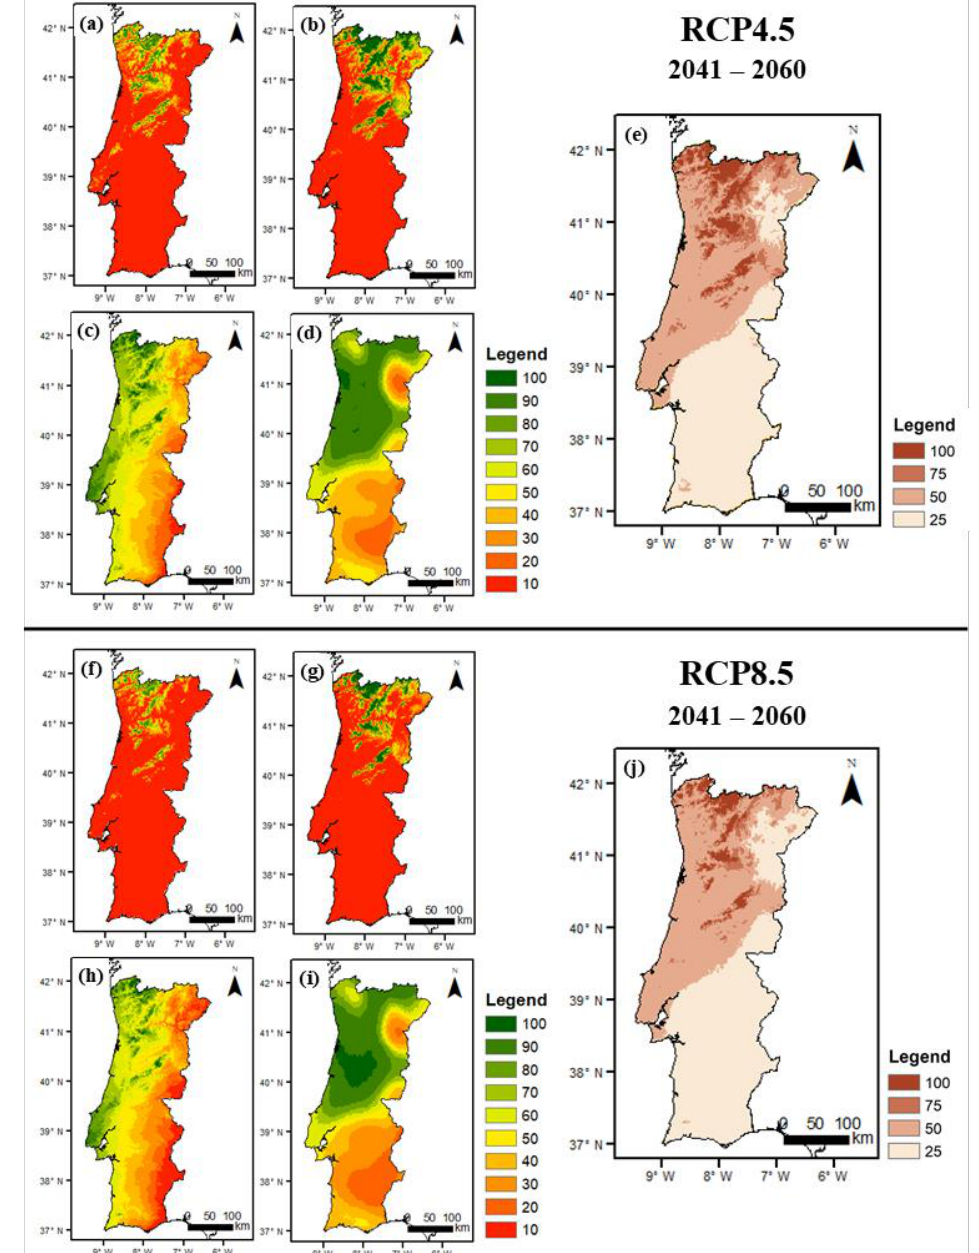
Figure 5. Mean percentage of occurrence of ( a , f ) growing degrees days between 1900 and 2400 ◦ C, ( b , g ) annual mean temperature between 8 and 15 ◦ C, ( c , h ) summer days with maximum temperature below 32 ◦ C, ( d , i ) annual accumulated precipitation between 600 and 1600 mm, and ( e , j ) chestnut suitability index, for 2041–2060, four GCM-RCM experiments, under RCP4.5 (top panel) and RCP8.5 (bottom